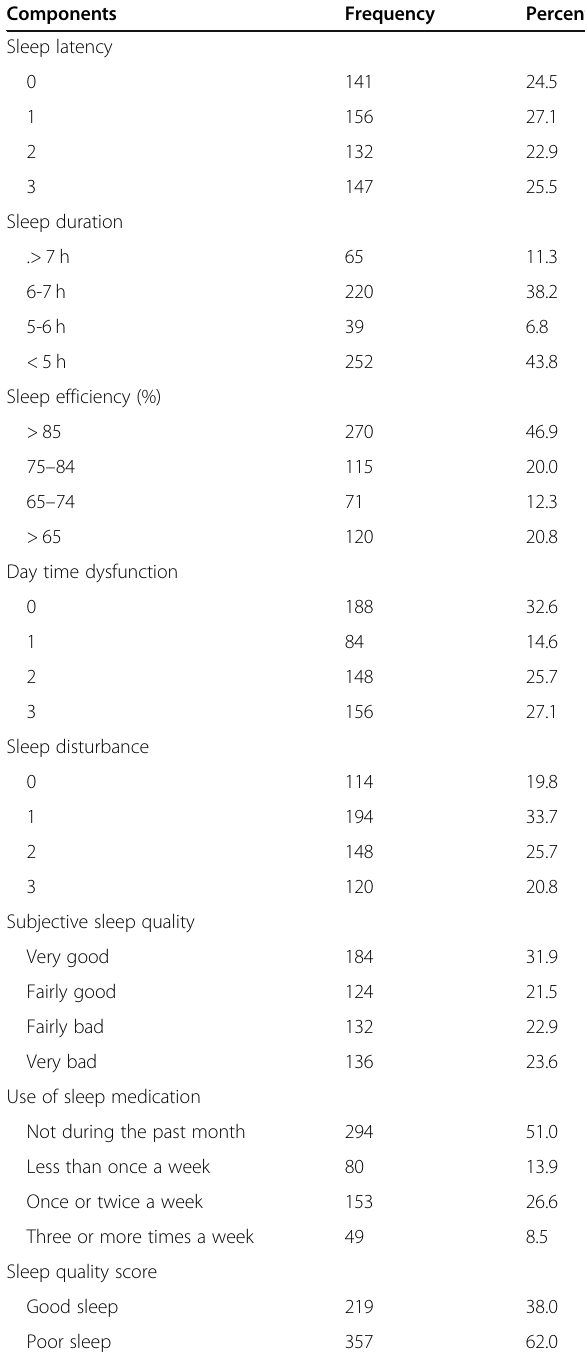
Table 3 Sleep quality and its component score among undergraduate medical students at Tikur Anbessa Specialized hospital, Addis Ababa, Ethiopia, 2019 ( N =